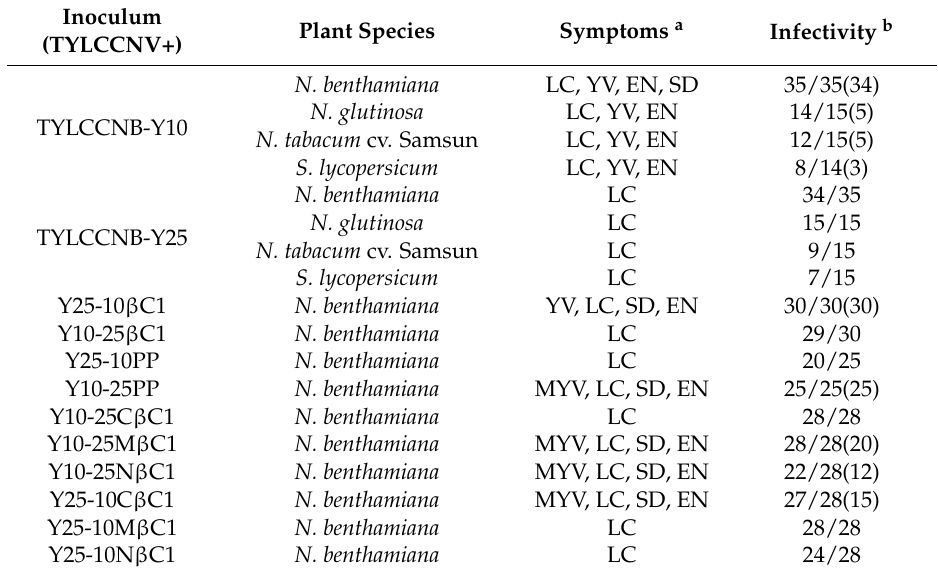
Symptoms induced by wild-type and hybrid betasatellites of TYLCCNB-Y10 and TYLCCNB-Y25 co-infected with